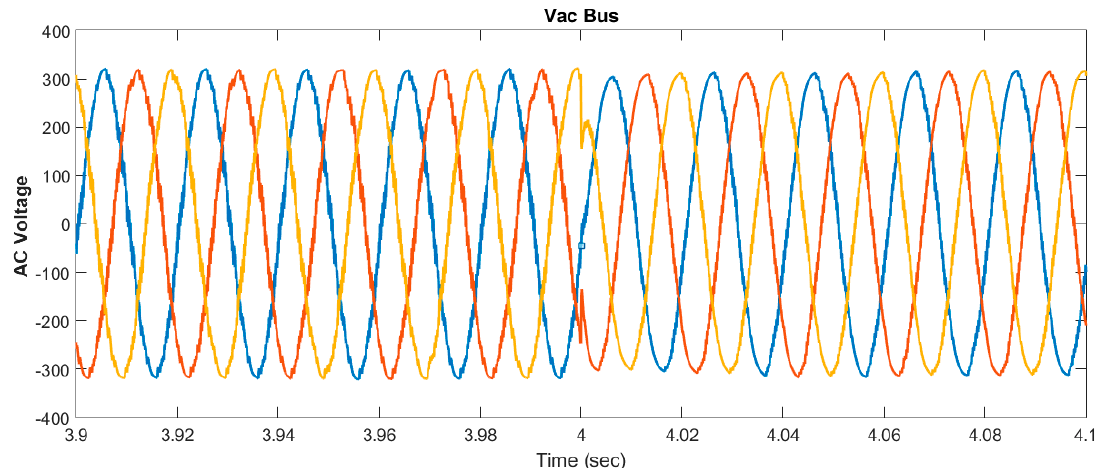
Figure 20. AC side voltage for AC charging.